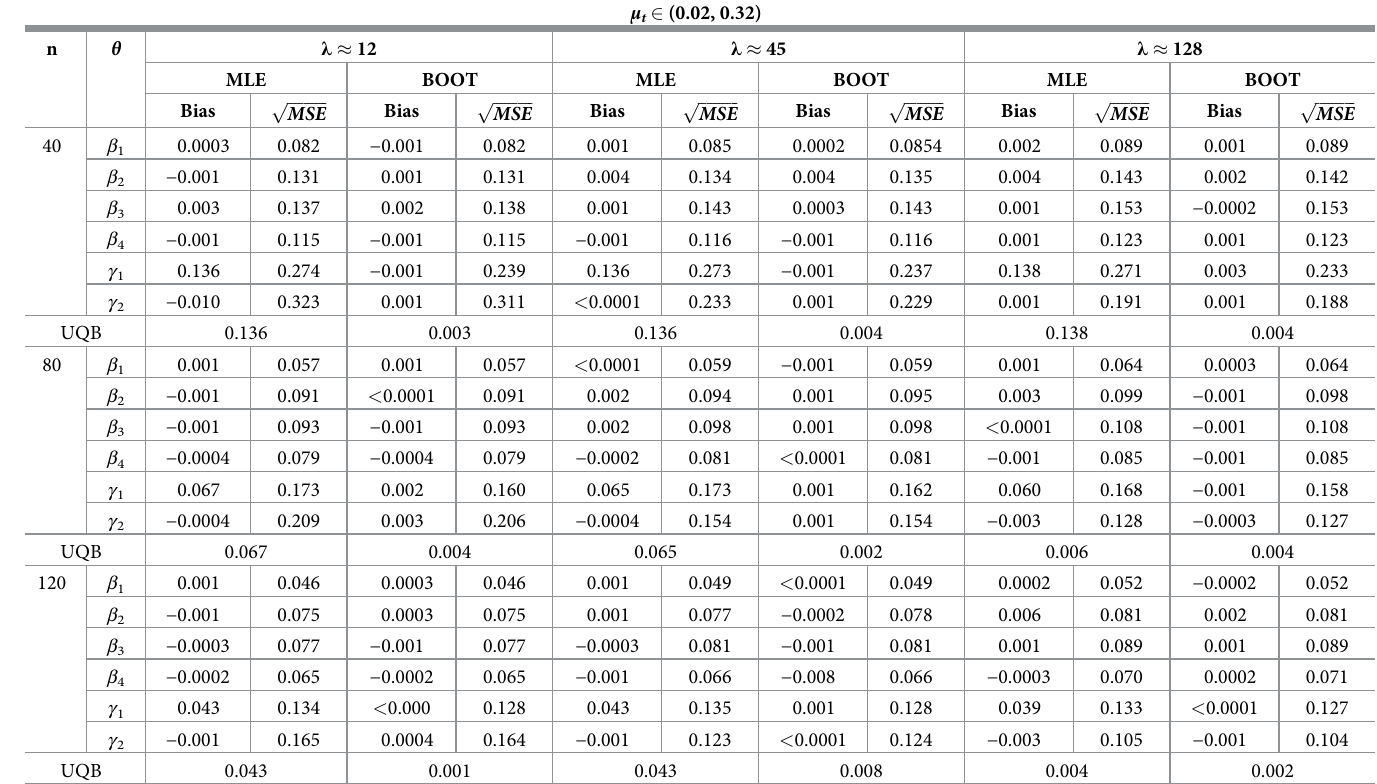
Table 1. Relative biases and root mean square errors of the Maximum Likelihood Estimators (MLEs-asymptotic) and bootstrap corrected MLEs of the model